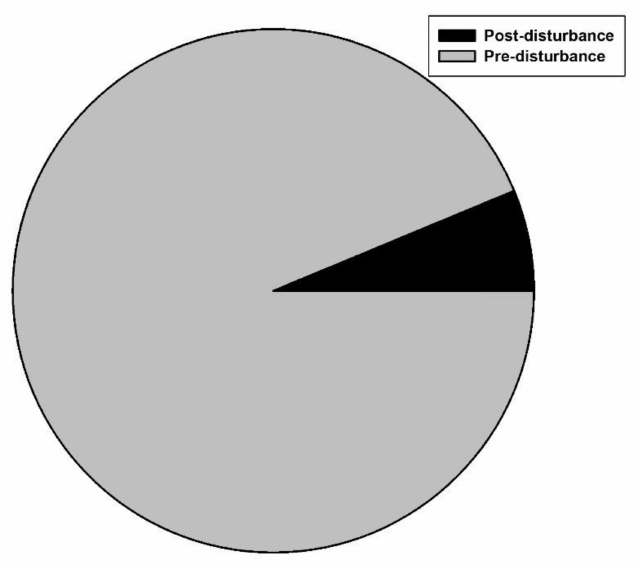
Figure 6. Proportion of 1999 basal area made up of stems of pre-disturbance vs. post-disturbance origin. Cohorts defined based on inferred 1989 dbh; all stems with inferred 1989 dbh > 1 cm were considered of pre-disturbance